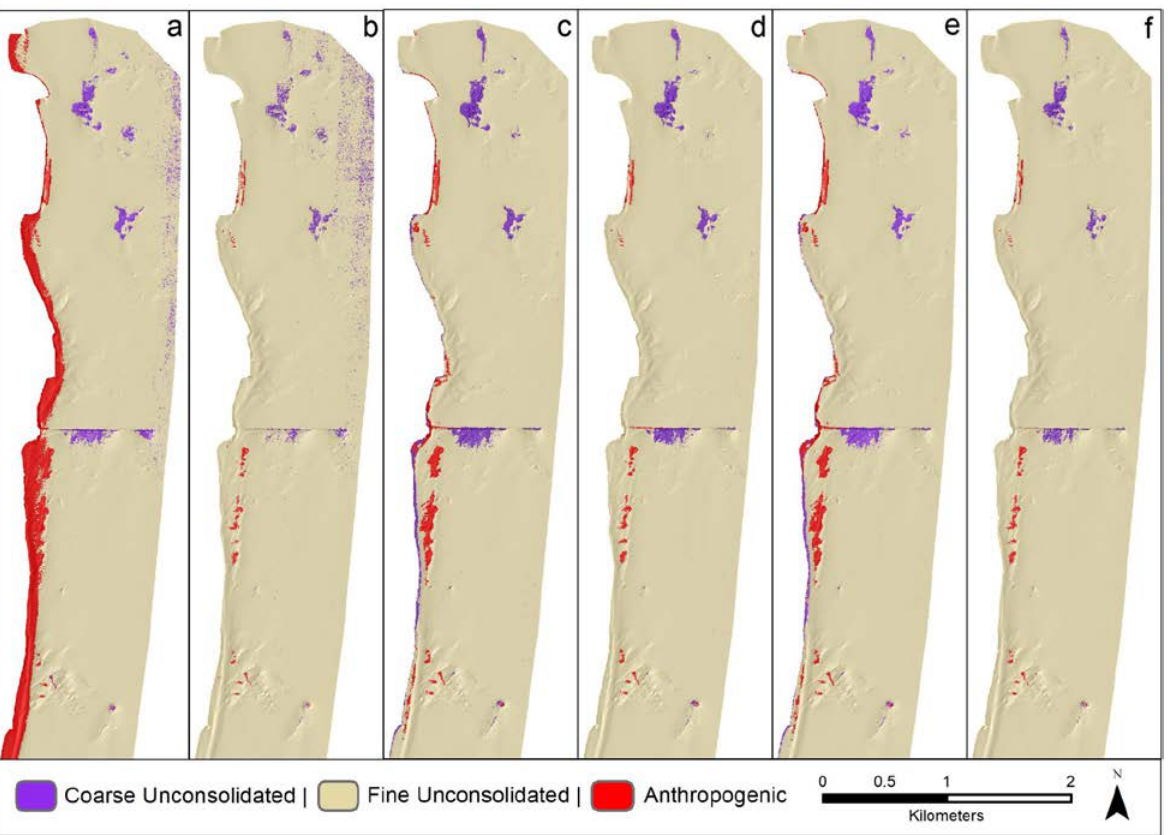
Figure 13. Tier 1 substrate component classification results using airborne data combinations for the north-central section of the study area: ( a ) CA MNF FU, ( b ) CA MNF FU with additional ROIs, ( c ) CA MNF FU + CA MNF WLR, ( d ) CA MNF FU + CA MNF WLR with additional ROIs, ( e ) CA MNF WLR + CA MNF FU + AB DE, and ( f ) CA MNF WLR + CA MNF FU + AB DE with additional ROIs.